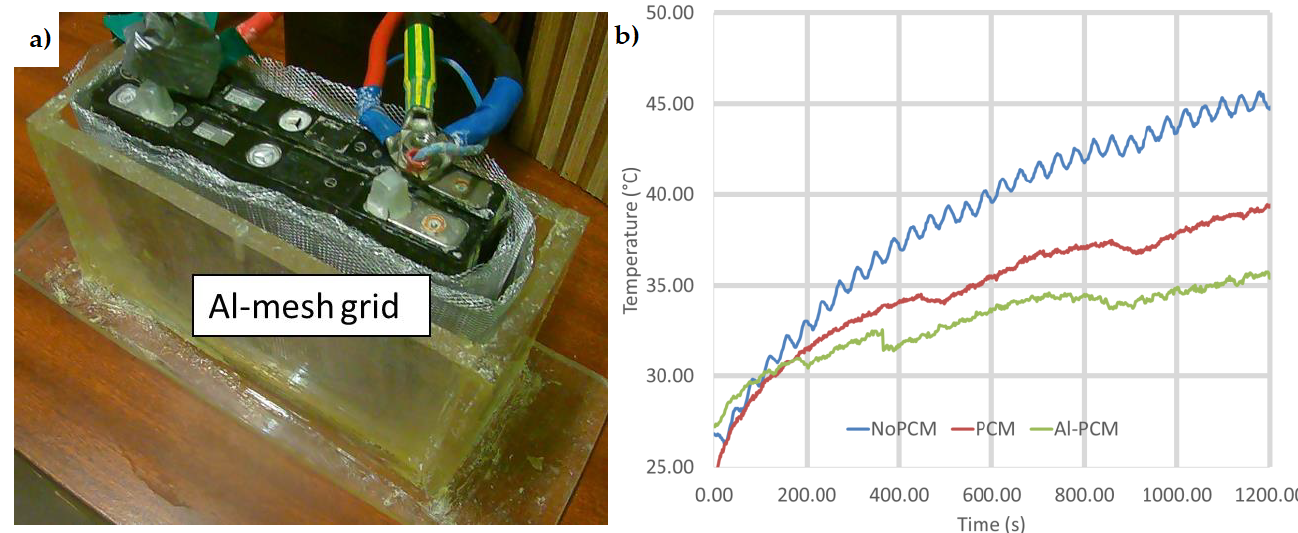
Figure 11. ( a ) Experimental test bench of the PCM-Al mesh grid; ( b ) the results of three case studies including no-PCM, pure PCM, and PCM-Al [47].